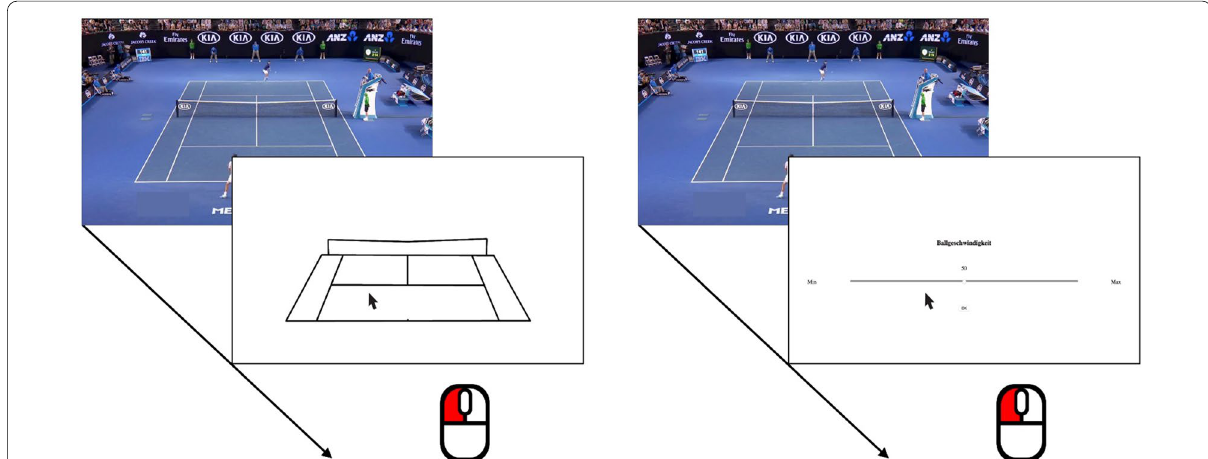
Fig. 1 Left panel: In the landing location anticipation block, participants indicated the anticipated landing position of the ball by clicking the location with the mouse. Right panel: In the speed judgment block, participants rated ball speed using an analogue slider (ranging from “min” to “max”; “Ballgeschwindigkeit” is German for “ball speed”) with the